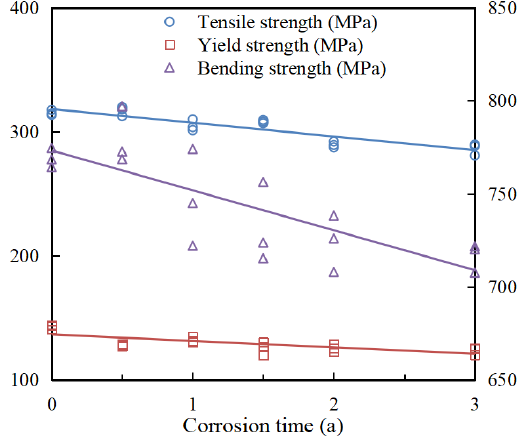
Figure 5. Change of tensile, yield, and bending strength over time.